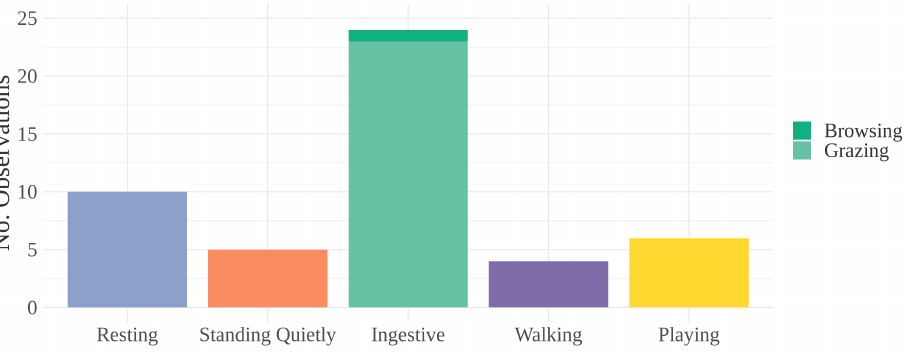
Figure 6. Behaviors observed immediately after E/M bout. “Ingestive” includes browsing and grazing. Arousal levels increase along the x -axis from left to